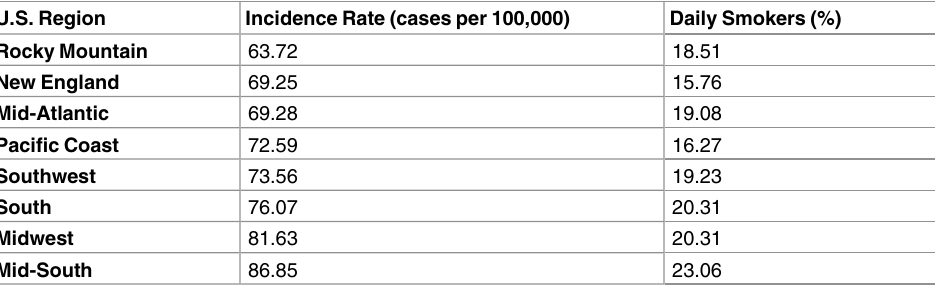
Table 13. Summarystatistics of average lung cancer incidence rates and average daily smokers in percentage in 8 U.S. geographic regions,